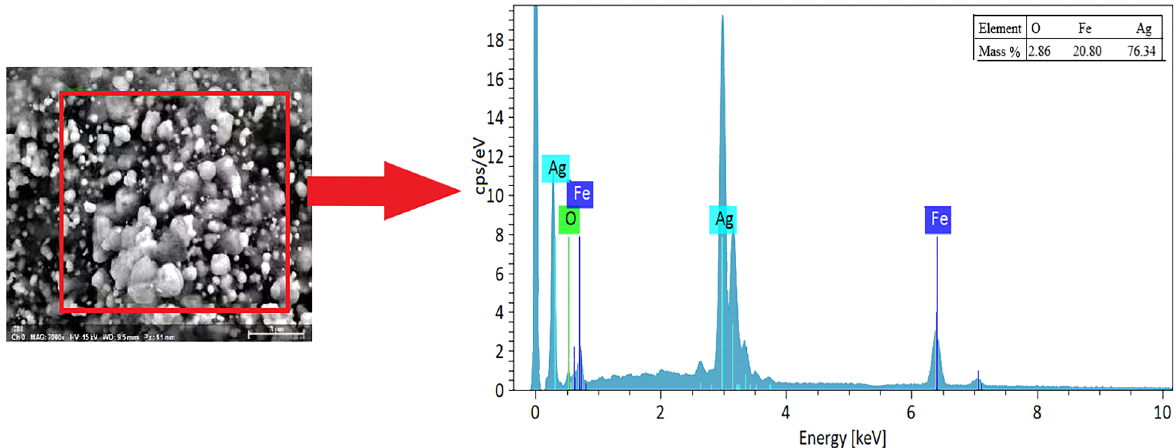
Figure 5: EDX spectrometry of AF -